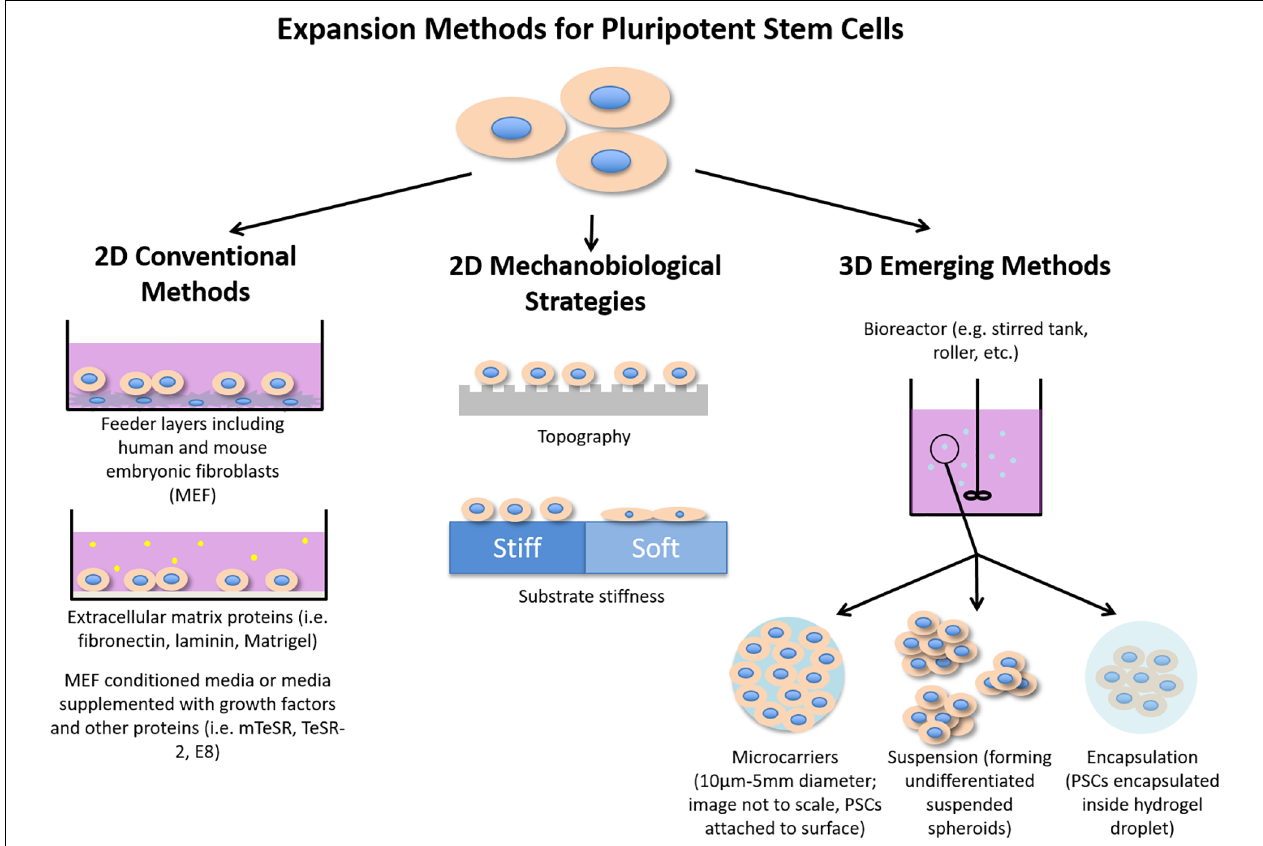
FIGURE 1 | Illustration summarizing conventional methods of PSC expansion as well as mechanobiological strategies and emerging 3D methods for enhancing PSC